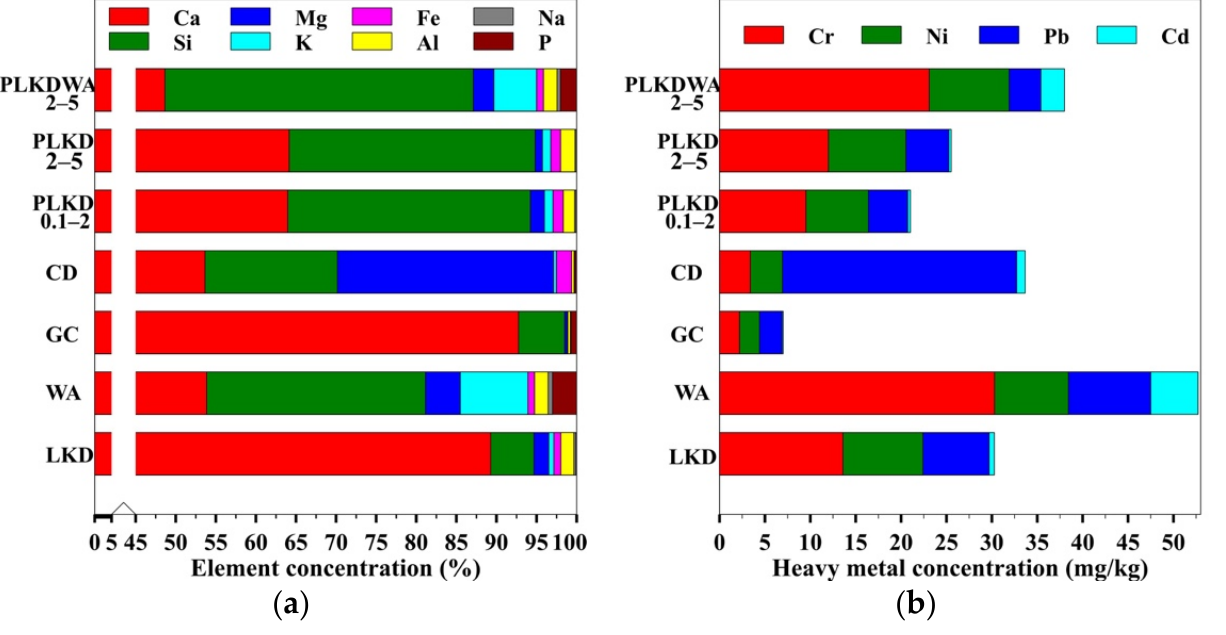
Figure 2. ( a ) Main nutrients and alumosilicates measured comprising liming materials. ( b ) Heavy metal concentration in liming materials.